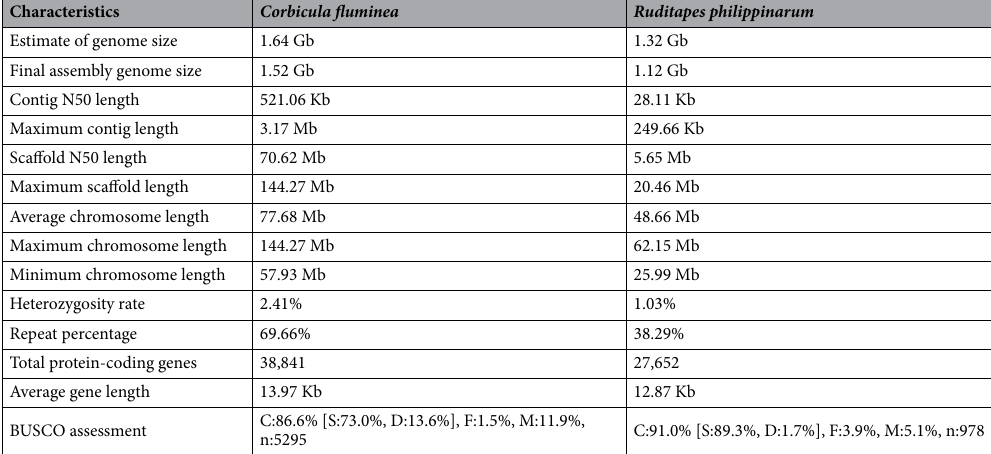
Table 1. Comparative analysis between the genome of Corbicula fluminea and the genome of Ruditapes